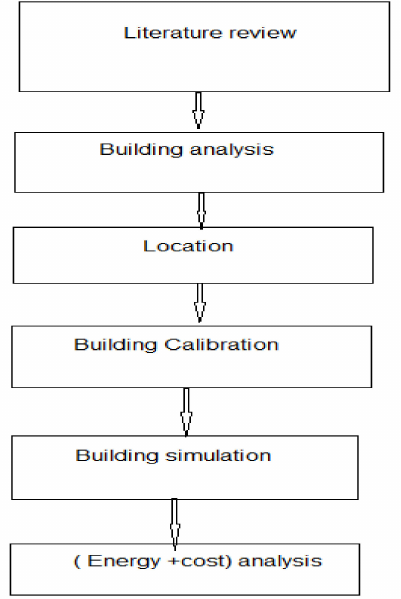
Figure 1. Research conceptual